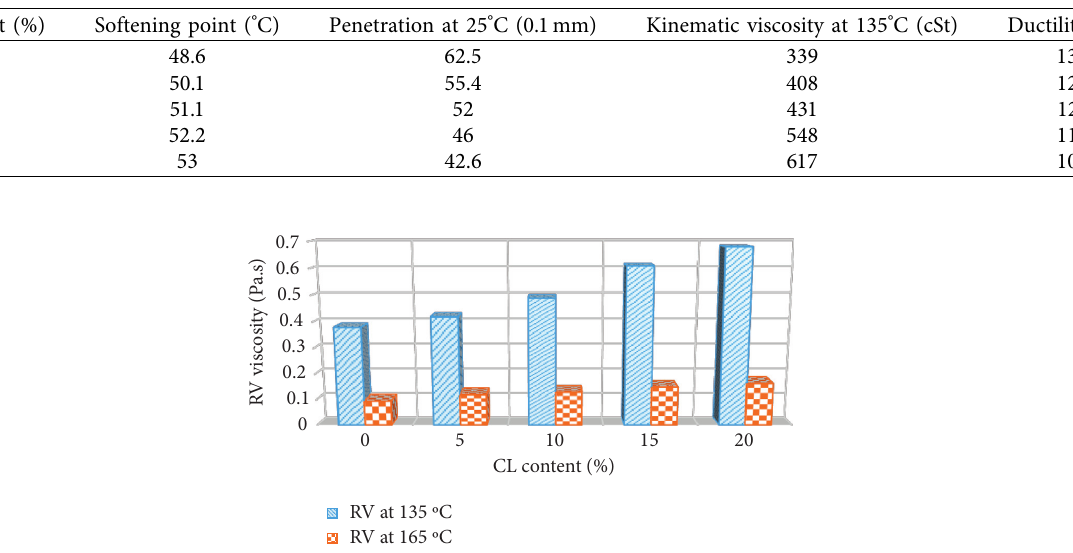
Figure 4: Elastic recovery test: (a) sample mold, (b) prepared sample, and (c) elastic recovery test apparatus. Table 4: The conventional asphalt binder test results.